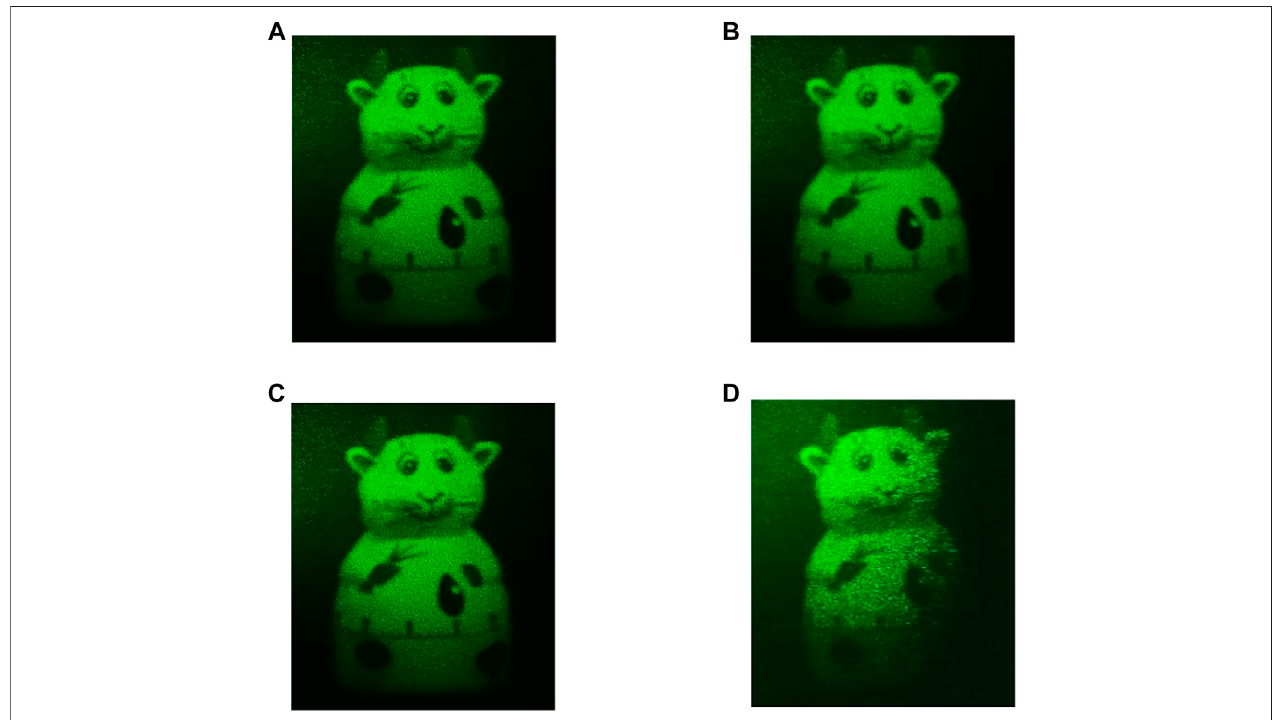
FIGURE6| Optical reconstructed images obtained from (A – B) theleft and right viewpoint ofthe proposed method, respectively, (C – D) theleft and right viewpoint of the traditional method, respectively.